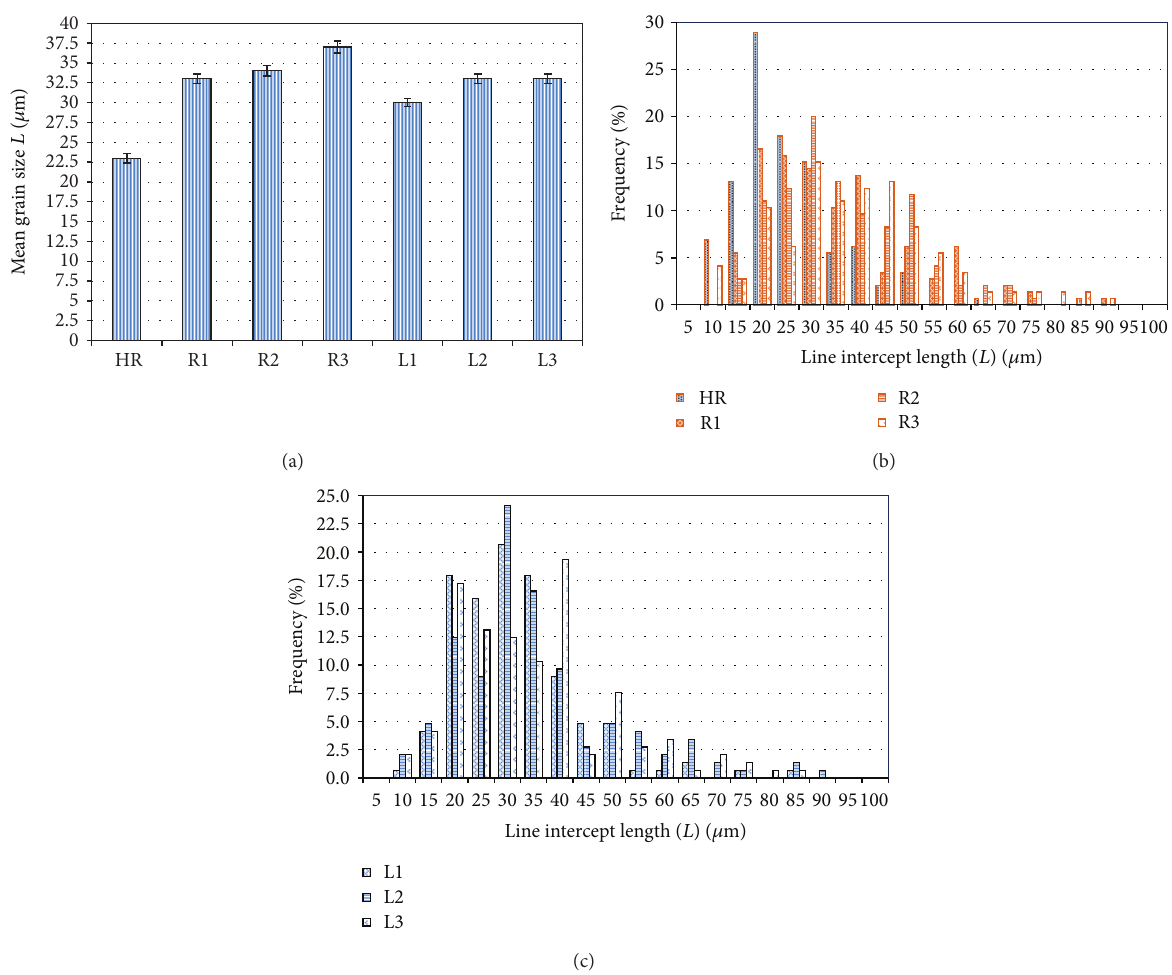
Figure 2: (a) Mean grain size of as received, final cold rolled, and annealed samples. (b) Grain size ( L ) distribution of final cold rolled samples. (c) Grain size ( L ) distribution of final annealed